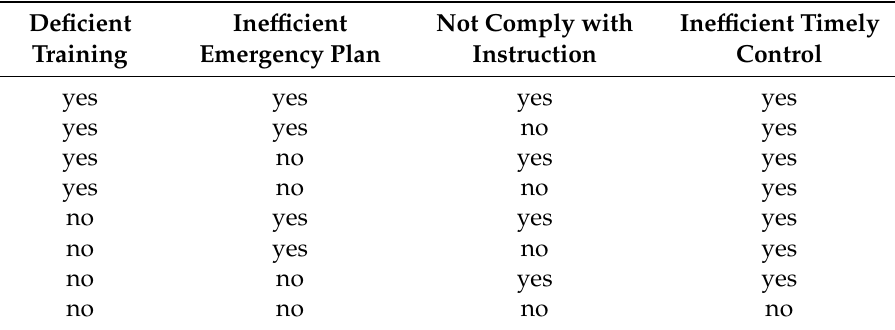
Table 2. CPT for the BN node ‘ine ffi cient timely